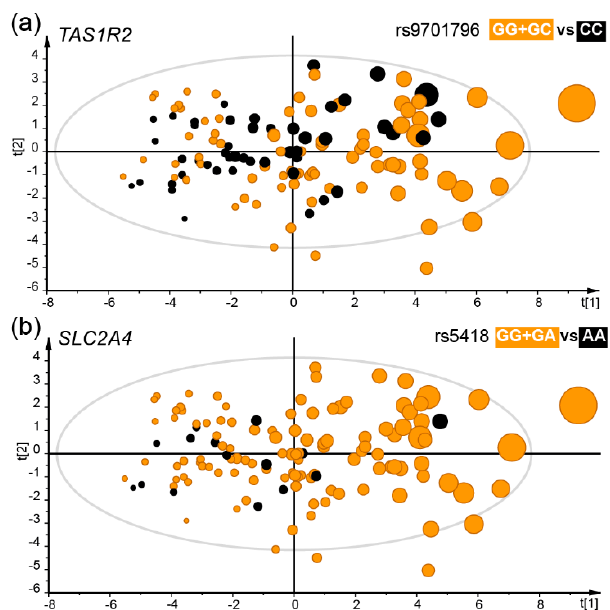
Figure 4. The distribution of genotypes illustrated in scatter plots from multivariate PLS modelling with daily intake of sweet foods as the dependent variable and various sweet food intake proxies and sweet, sour and bitter food and tastes as the independent block. The model explained (R 2 ) 41% and predicted (Q 2 ) 20% after validation by the “leave-one out” method. Each dot represents a participant and the size illustrates the number of sweet food intakes per day. Participants in the TAS1R2 rs9701796 GG + GC genotype group ( a ), or the SLC2A4 rs5418 GG + GA genotype group ( b ) are shown in orange. Both these genotype groups were positively associated with sweet food intake. The scatter plots are score-loading plots where the scores t(1) and t(2) are the new created variables summarizing the x-variables. The oval circle illustrates the tolerance ellipse based on Hotellings of T2, and observations located outside the ellipse indicate potential